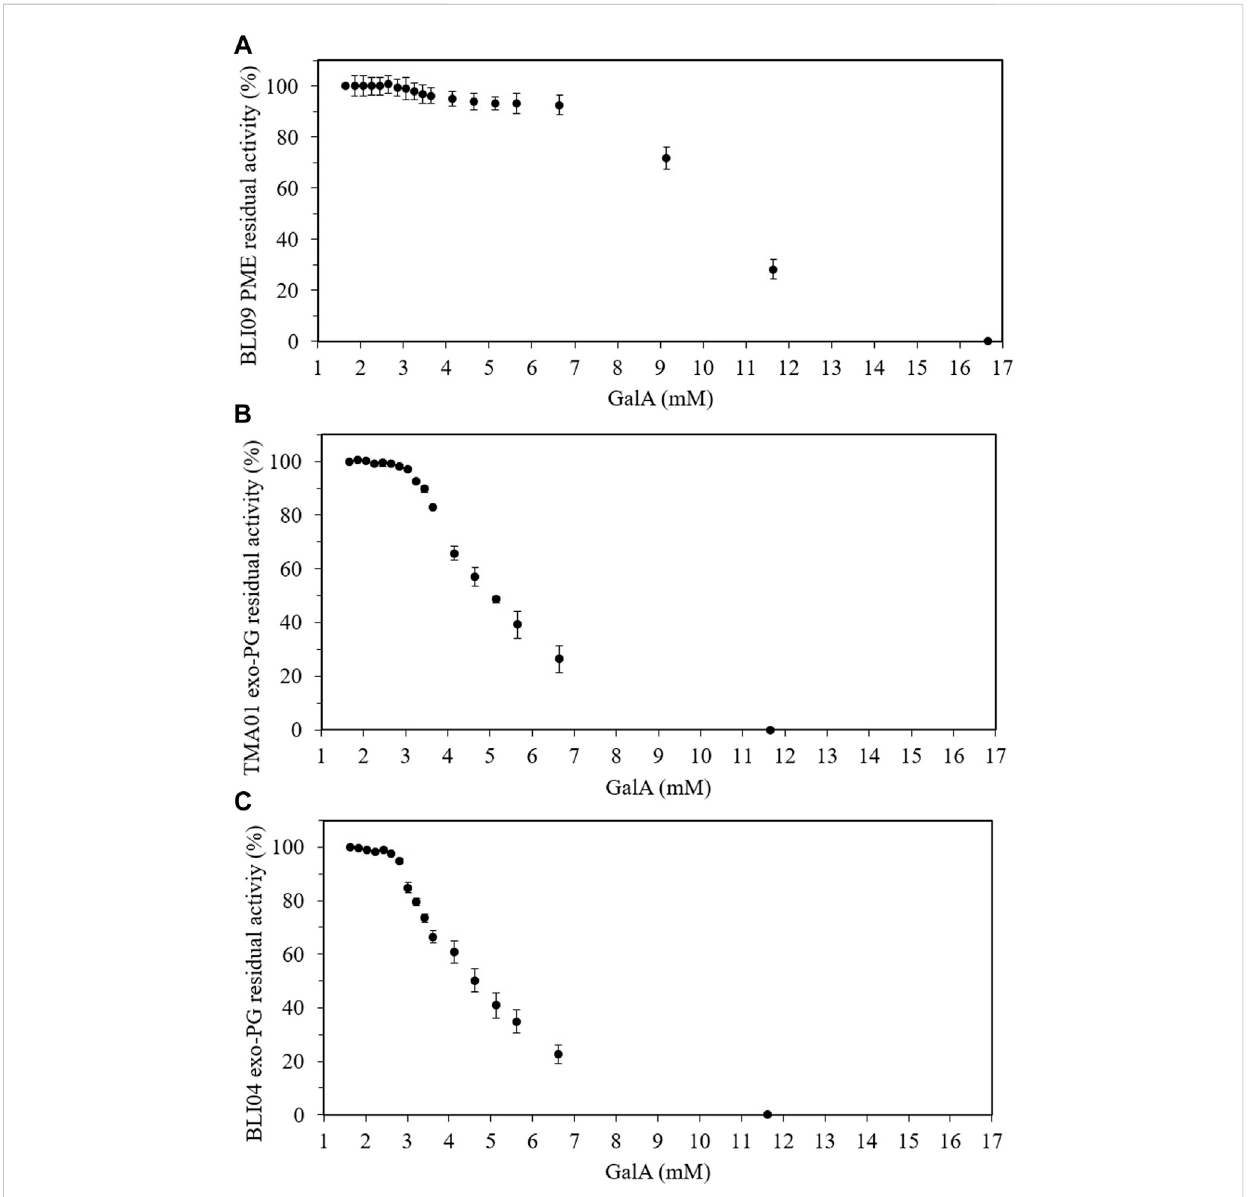
FIGURE 6 Product inhibition effect of GalA on pectinases from co-expression constructs 3 and 4. (A) GalA effect on BLI09, (B) TMA01 and (C) BLI04. The reactions werecarried outat50 ° Cand 300 rpmfor 30 minusing 0.5%(w/v)apple pectin (in 20 mMphosphatepH 7),and0.5and 2 U mL − 1 ofTMA01 and BLI04, respectively. The BLI09 activity was calculated in the volume containing the U mL − 1 of TMA01 mentioned before (Supplementary Table S3). Error barsrepresent one standarddeviationfrom themean(n= 2).PME:pectin methylesterase,exo-PG:exo-polygalacturonase, GalA:galacturonic